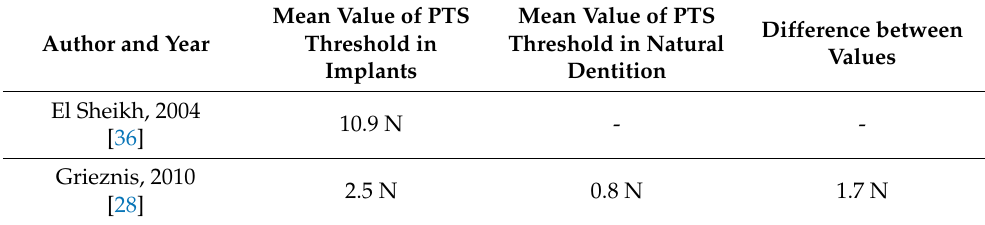
Table 2 refers to clinical investigations that studied passive tactile sensibility (PTS) thresholds in natural dentition and implant prosthesis, measuring the differences in values between them. Table 2. Passive tactile sensibility (PTS) thresholds in natural dentition and implant prosthesis.